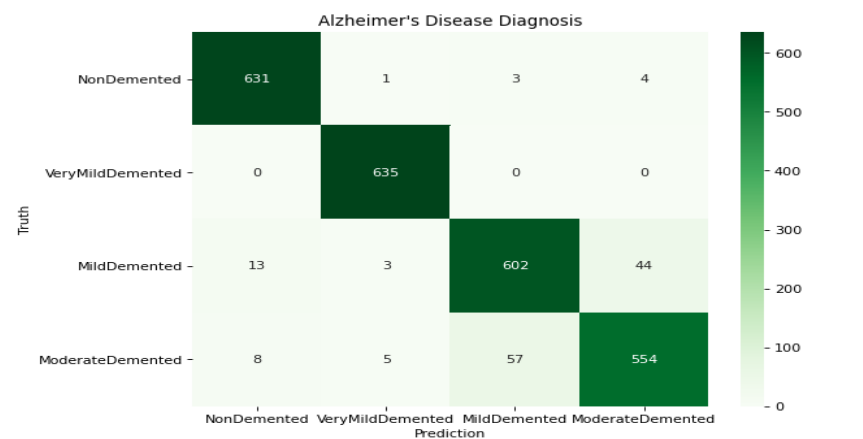
Figure 16. Trend of the Metrics During Training.